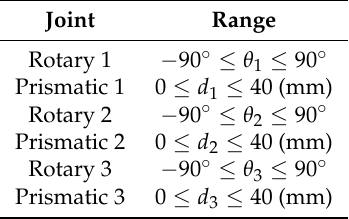
Figure 12. Workspace of the 6-DoF redundant planar manipulator robot. Table 3. Mechanical limitations of the 6-DoF redundant manipulator planar robot